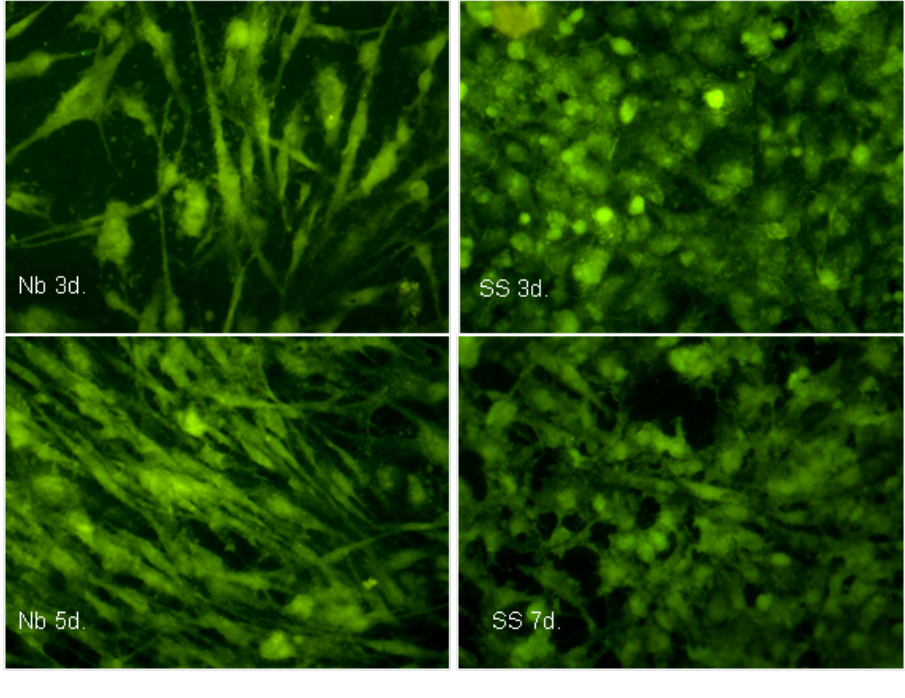
Figure 8. Morphology of the human osteoblast cells cultured on the Nb film during 3 (A) and 5 days (B) and stainless steel surfaces at 3 days (C) and 7 days (D). The cytoskeleton of well differentiated osteoblasts normally assumed an elongated appearance